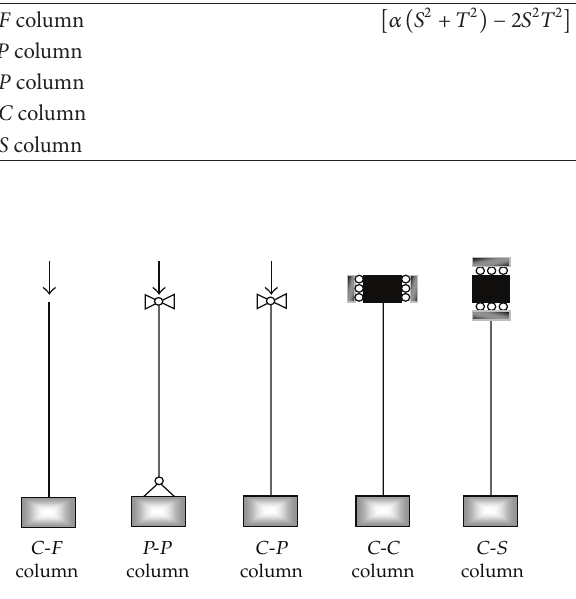
Figure 2: Various end conditions for restrained